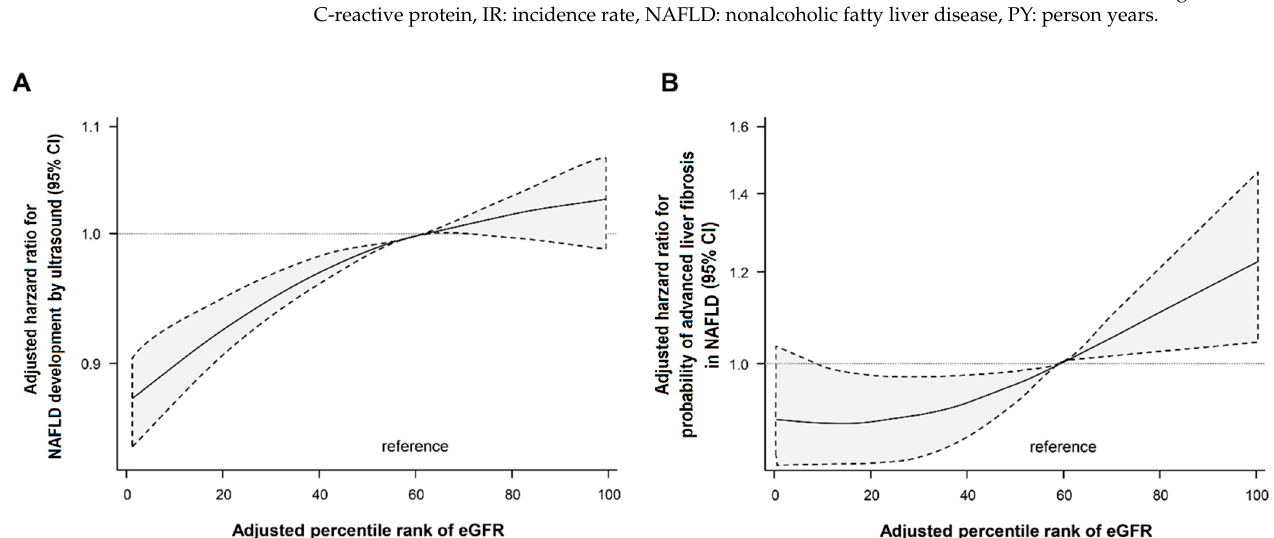
Model 1: adjusted for age, sex, center, and muscle mass. Model 2: additionally adjusted for BMI, smoking status, regular exercise, history of diabetes, dyslipidemia, and hypertension. Model 3: additionally adjusted for hs-CRP and HOMA-IR. BMI: body mass index, CI: confidence interval, eGFR: estimated glomerular filtration rate, HOMA-IR: homeostasis model assessment of insulin resistance, HR: hazard ratio, hs-CRP: high-sensitivity C-reactive protein, IR: incidence rate, NAFLD: nonalcoholic fatty liver disease, PY: person years.